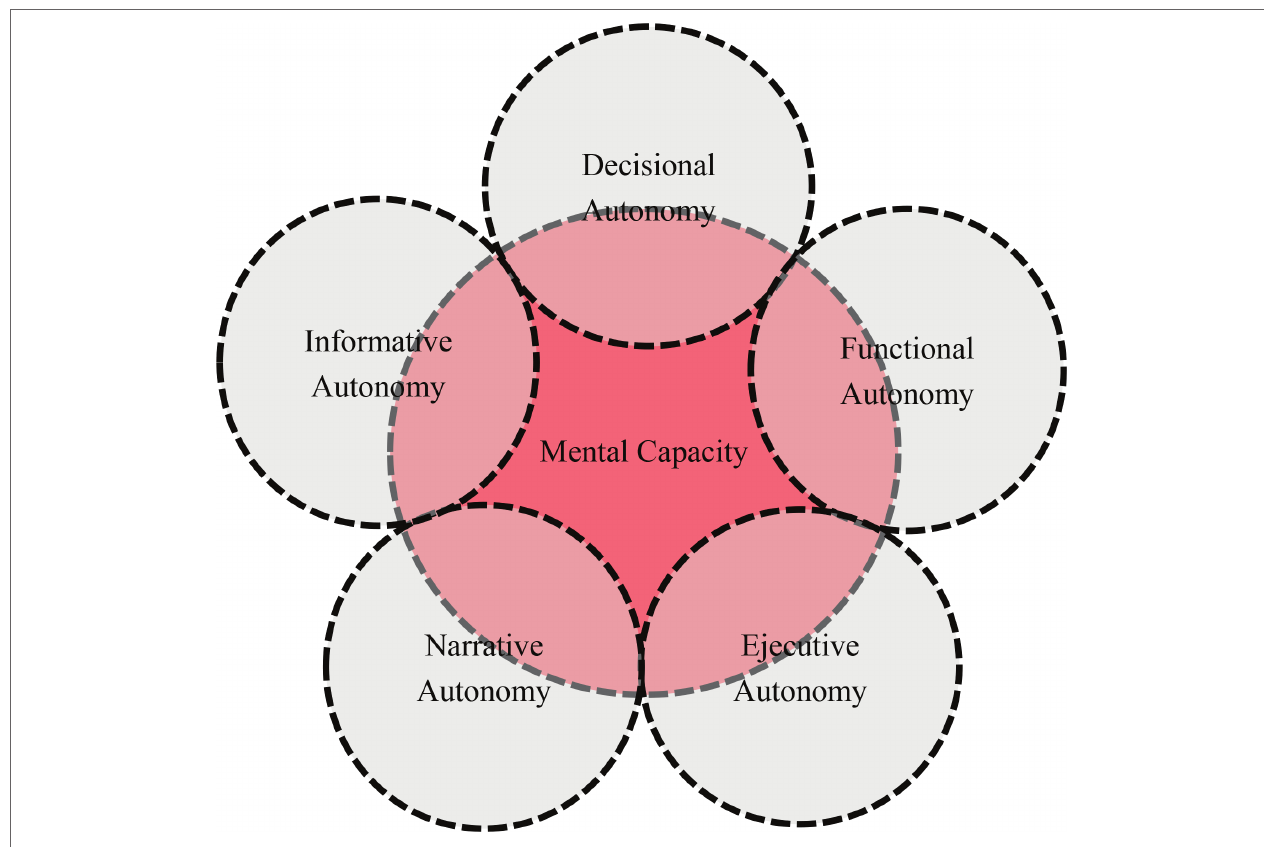
FIGURE 2 | Mental capacity, necessary element of patient